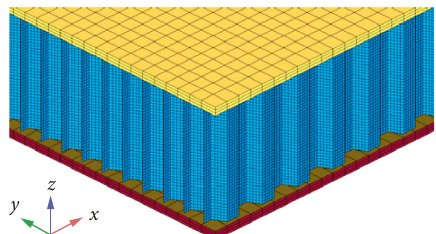
Figure 2: Whole entity modeling.